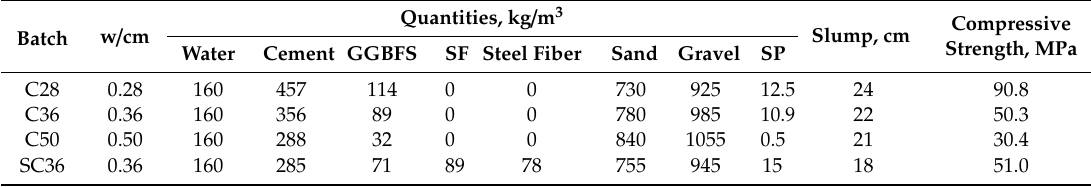
Table 3. Concrete mixture proportions and results of compressive